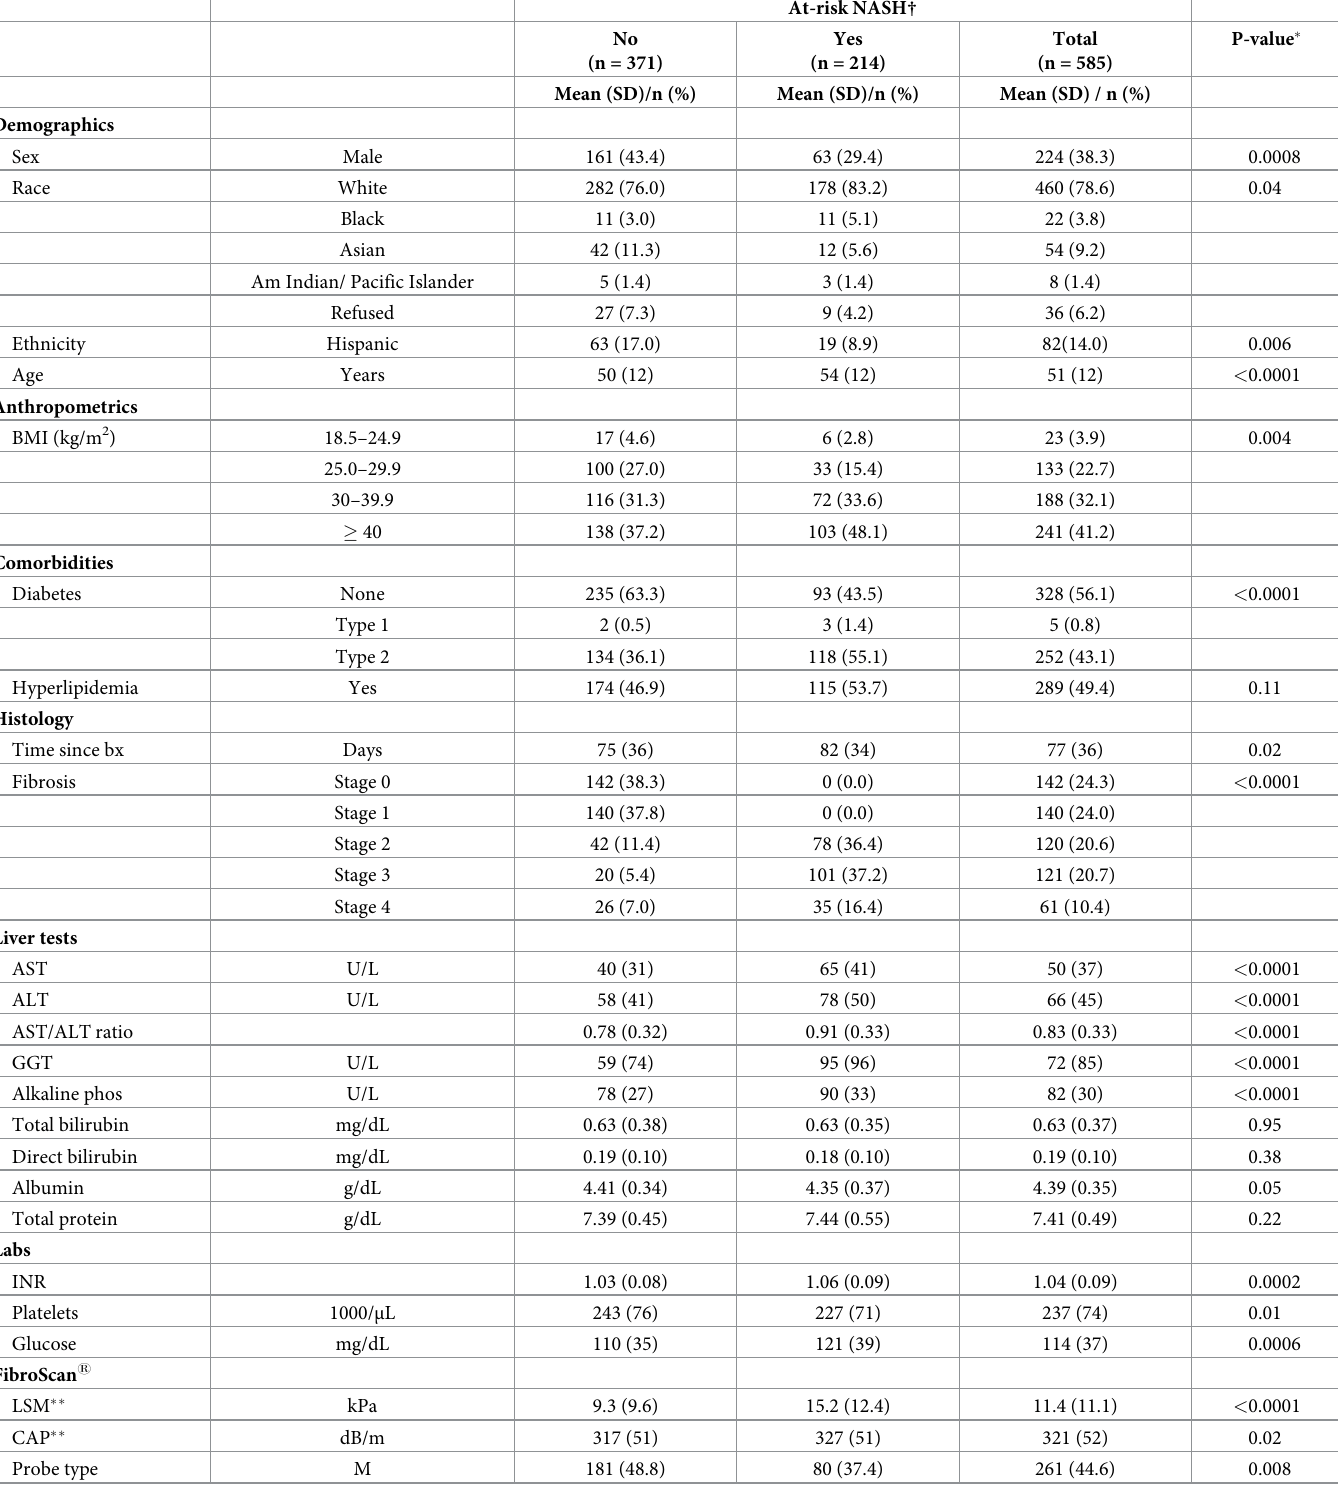
Table 1. Characteristics of the population by NASH activity and fibrosis